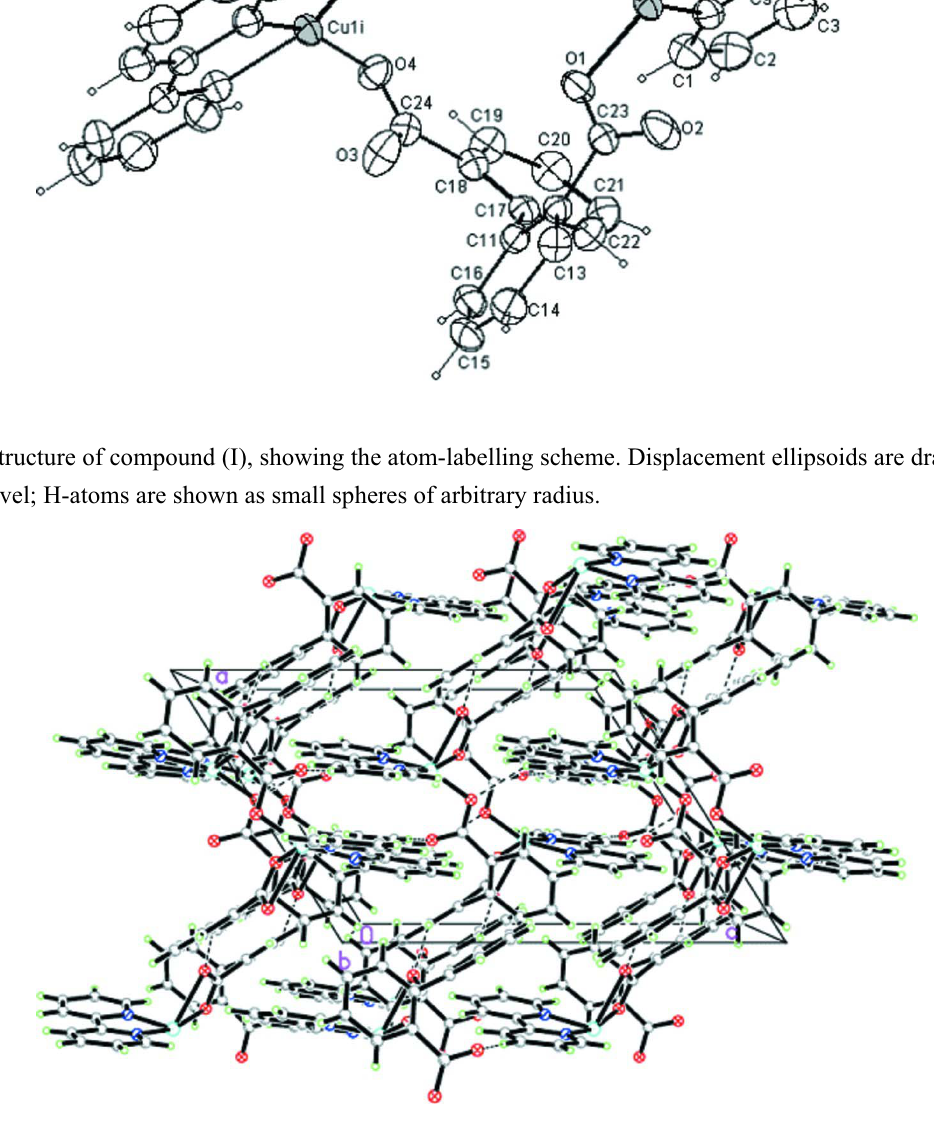
Figure 2 View of the 3D hydrogen-bonded network in the packing of the title compound.The packing is viewed along the b axis; C —H···O interactions are shown as dashed